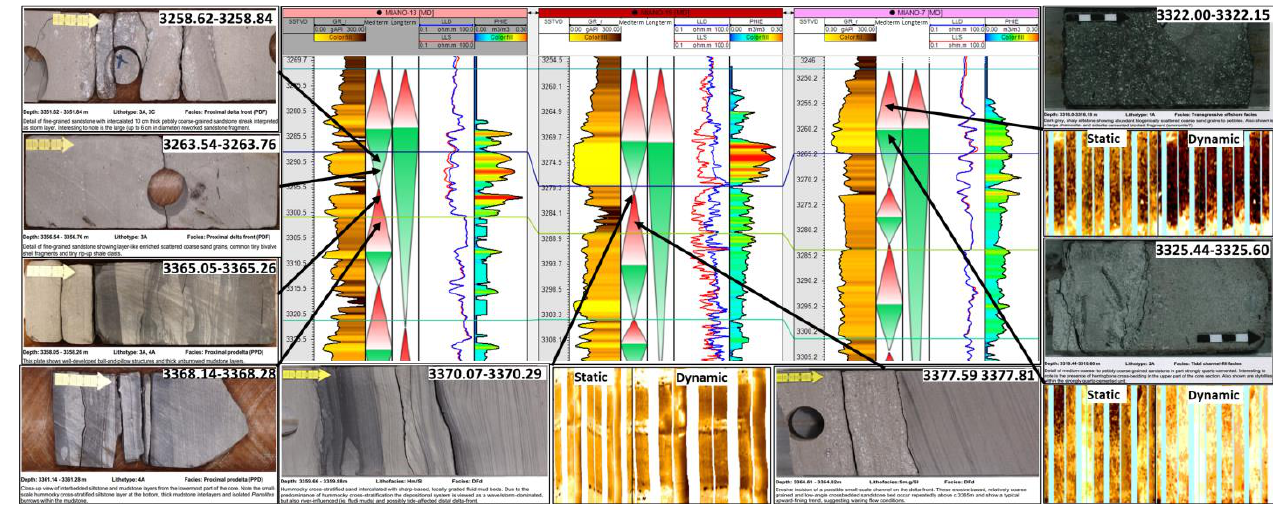
Figure 6. The core samples and MFI logs in three coring wells in the Miano gas field. The main coring intervals concentrate in Unit 4 and Unit 5. The lithology in Unit 4 is light grey to grey fine-grained sandstone to siltstone with shale layers. The depositional structures in this unit indicate possible local tidal affect. The lithology in Unit 5 presents a trend of deepening upward. Grey coarse-grained sandstone develops at the lower part of the unit and dark grey shaly siltstones with burrows and bioturbations develop in the upper part of the unit.